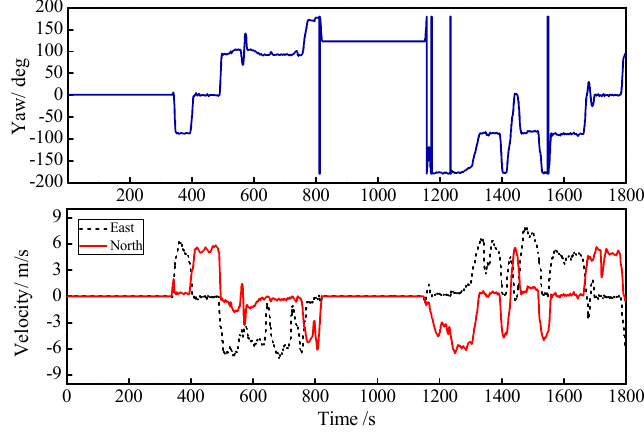
Figure 11. Curves of the yaw, east velocity, and north velocity.